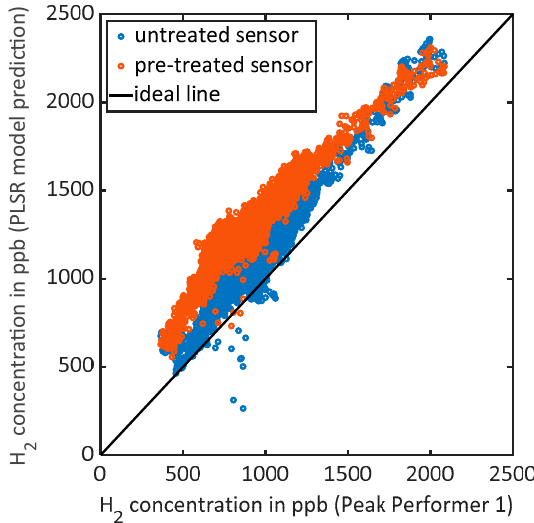
Figure 5. Concentrations obtained from the PLSR model predictions of both sensors vs. concentration indicated by the Peak Performer 1 .